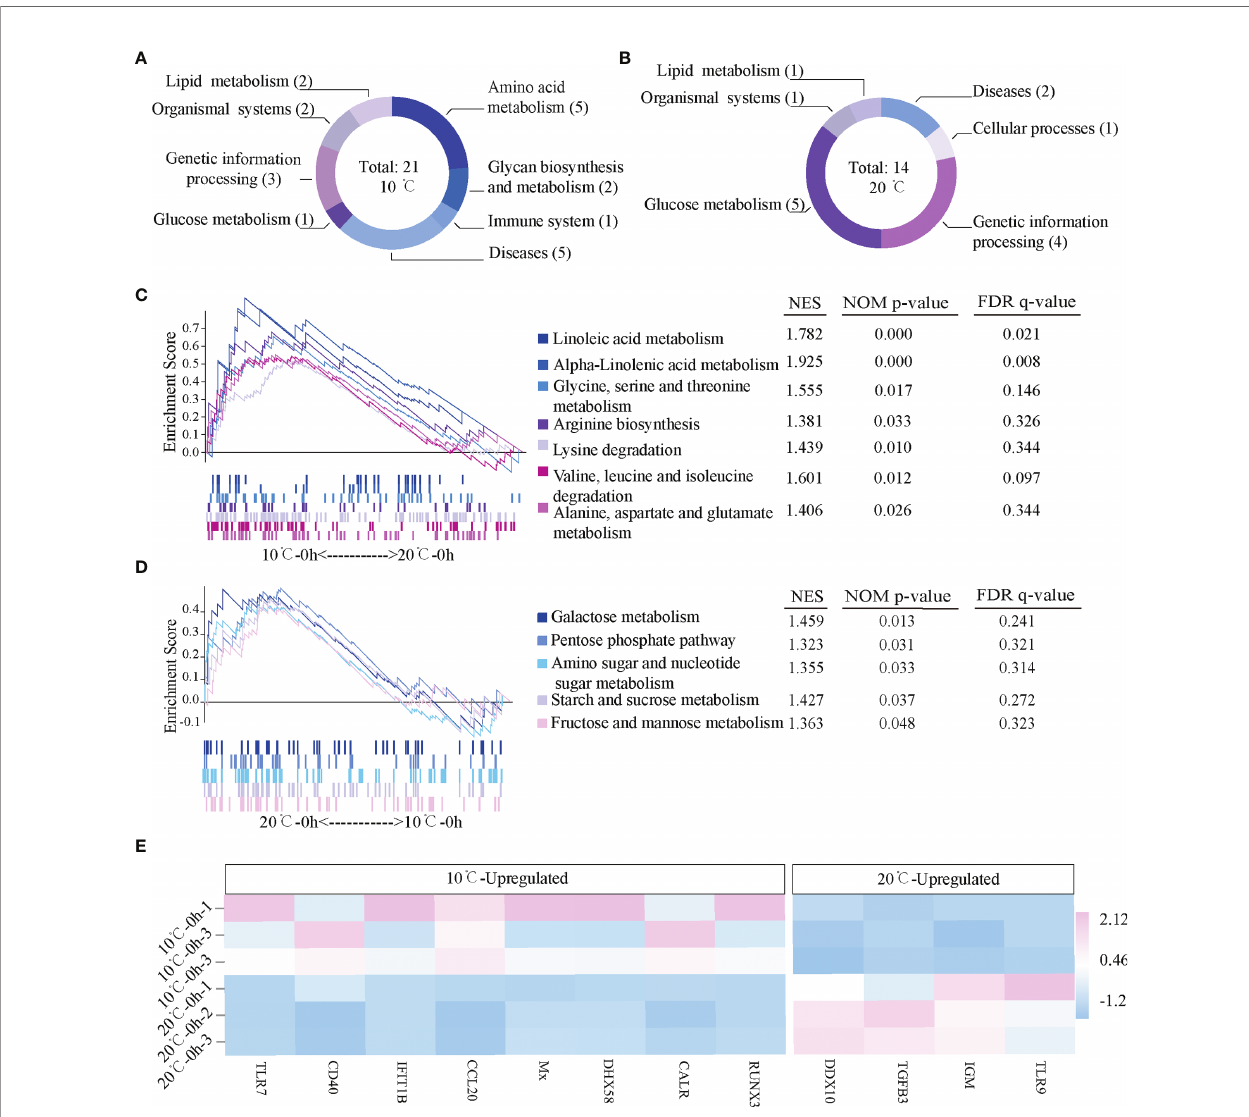
FIGURE 3 | Gene expression pro fi les in the mIgM + B lymphocytes of uninfected fl ounder maintained at 10°C and 20°C. (A, B) The activated signal pathways at 10°C and 20°C. (C, D) Metabolic pathways activated in 10°C and 20°C. Normalized enrichment score (NES) and values of the pathways with p < 0.05 are presented. (E) The heatmap of immune related genes at 10°C and